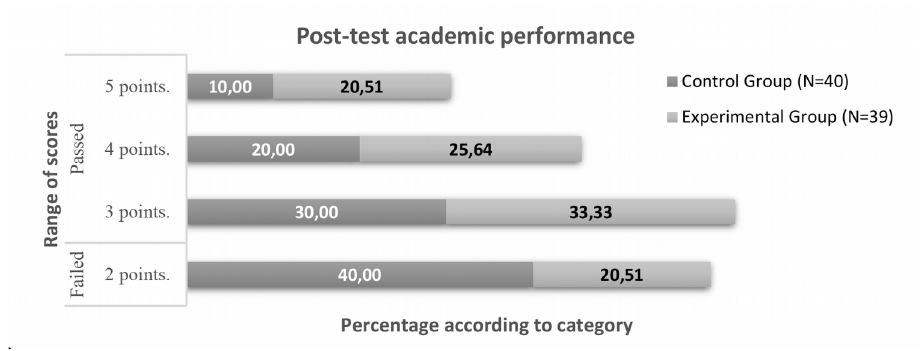
Figure 3. Post-test results of the objective tests applied in